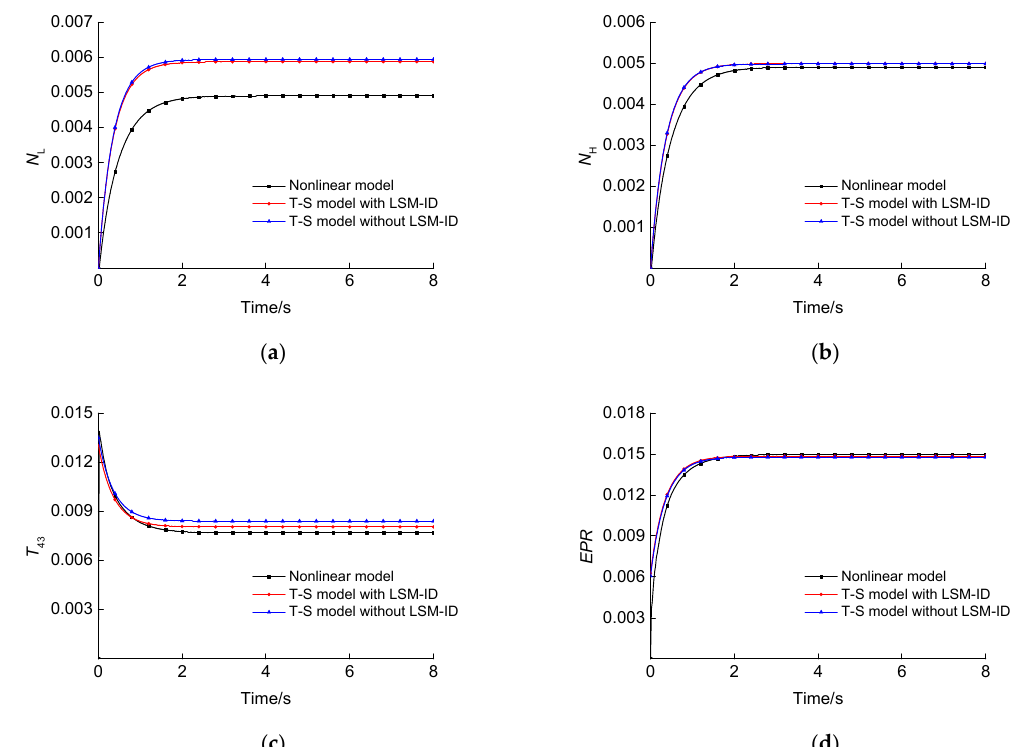
Figure 6. Response comparison under 1 km and 0.15 Mach. ( a ) N L response comparison. ( b ) N H responses. ( c ) T 43 responses. ( d ) EPR responses.